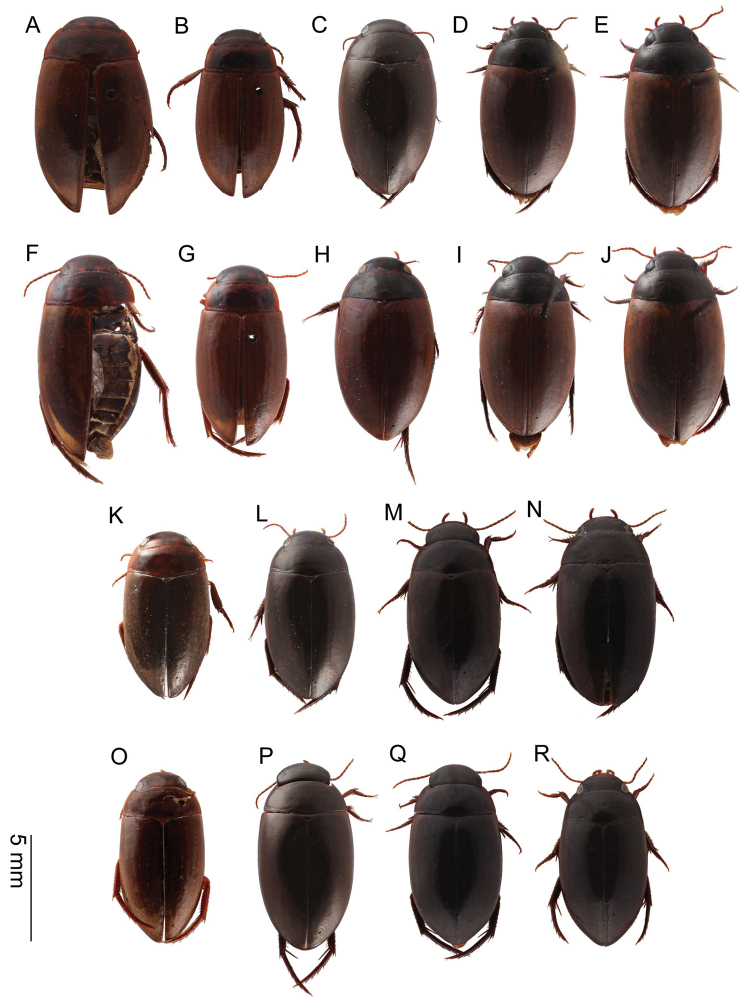
Agabus spp., habitus of males in dorsal view A, FA.
sjostedtiB, GA.
dytiscoides; C, HA.
ruwenzoricusD, IA.
raffrayiE, JA.
pallidusK, OA.
anguluverpus sp. nov. L, PA.
austellus sp. nov. M, QA.
riberae sp. nov. N, RA.
agulhas sp. nov.